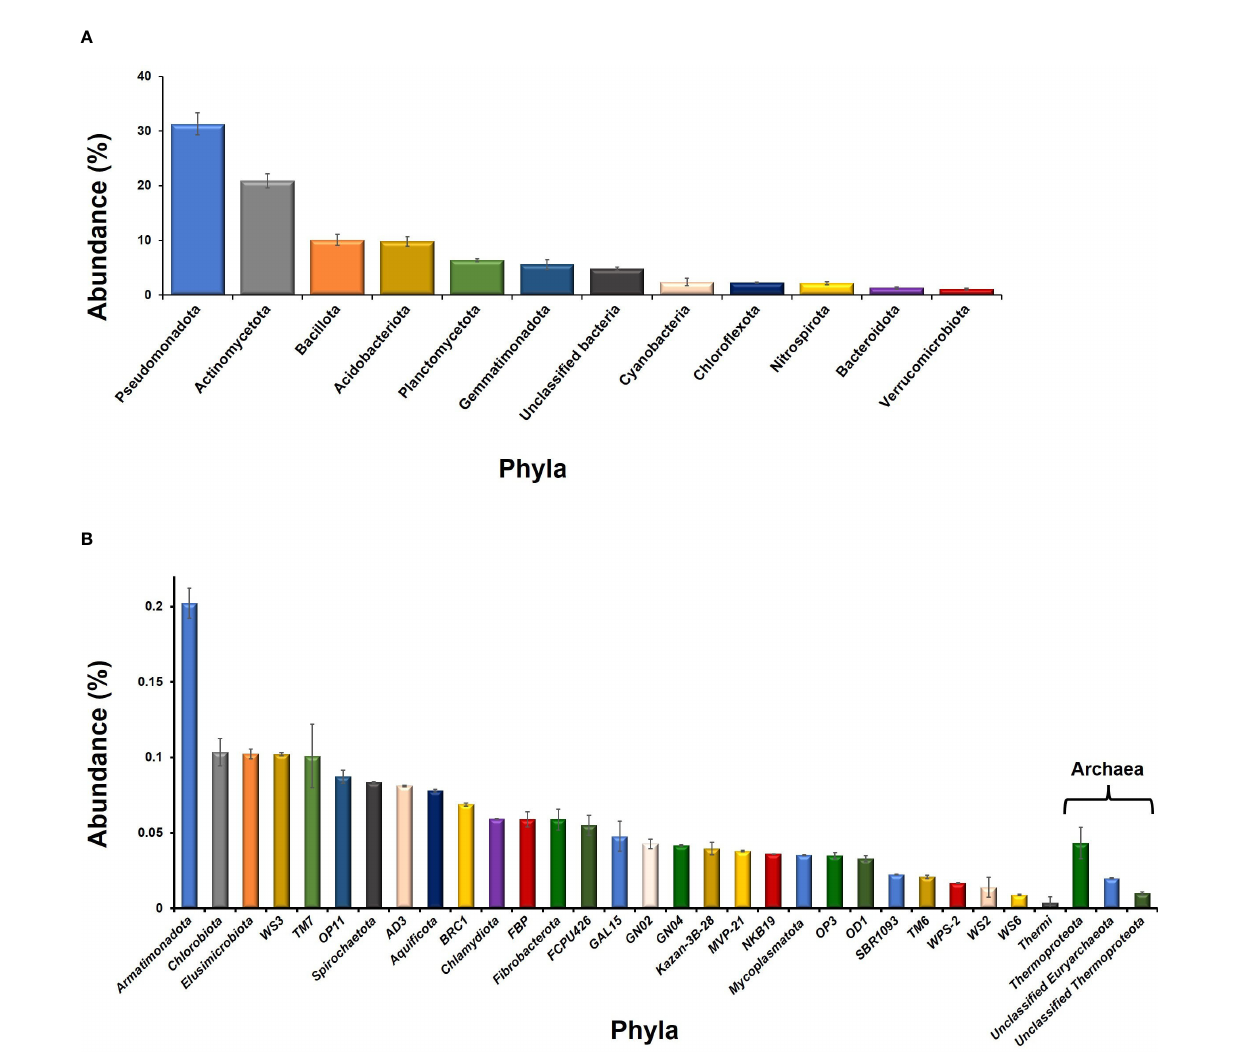
FIGURE 1 Taxonomic distribution of the phyla observed in the rhizosphere of L. camara L. Whereas, phyla having ≥ 1% abundance and ≤ 1% abundance are plotted as (A, B)